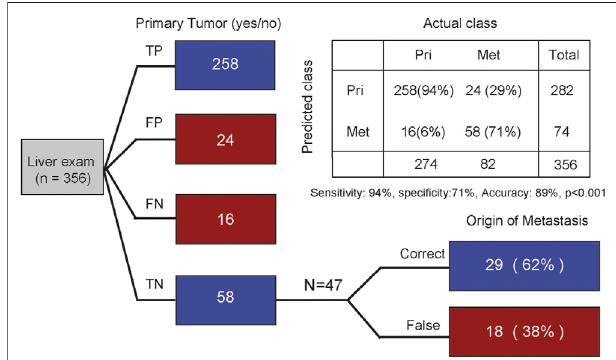
FIGURE4| TracingtheoriginofmetastatictumorbasedonMS.The fi rst column distinguishes whether it is primary liver cancer. The second column traces the origin of metastatic cancer. TP, true positive; FP, false positive; FN, false negative; TN, true negative. Indicated are sample numbers and detection rates in